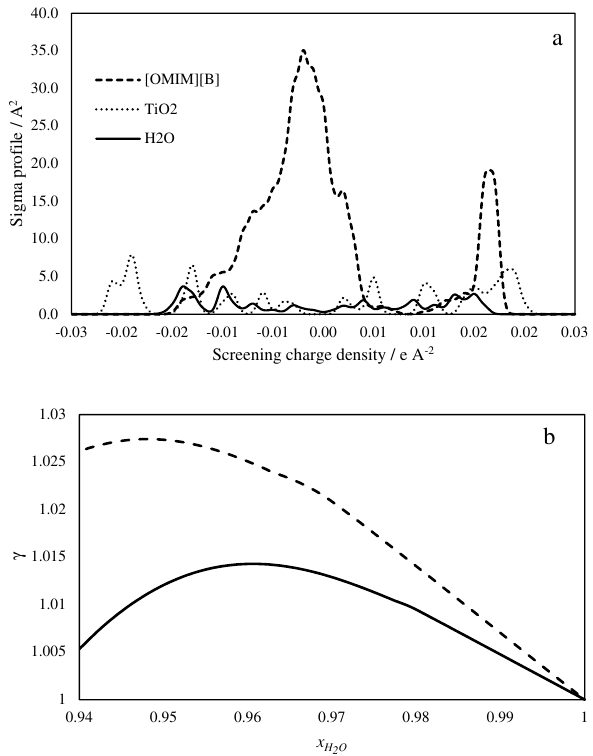
Figure 2. The results of COSMO-SAC modeling for the nanofluid containing water + IL + TiO 2 : ( a ) sigma- profiles of the components, ( b ) water activity coefficient plot against its mole fraction in 0.01 (solid line) and 0.02 (dashed line) mol fraction of TiO 2 at 25 °C.